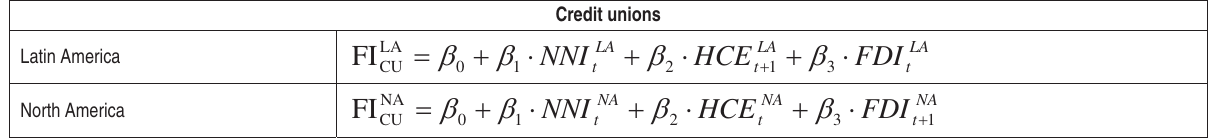
Table 3 (cont.). Distribution-lag models for cooperation evaluation between expansion of access to insurance companies’ and credit unions’ services and financial and economic development parameters of the world regions